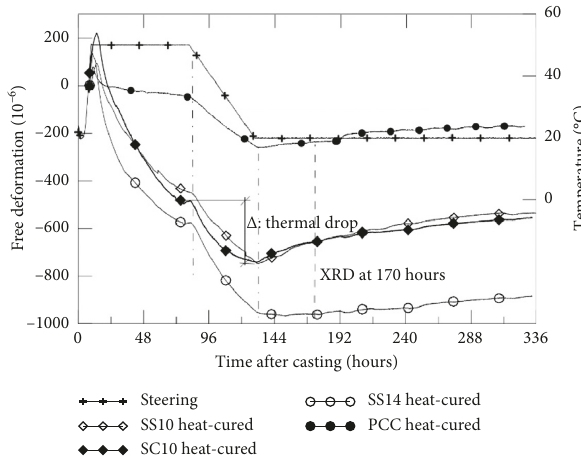
Figure 6: Free deformations on heat-cured samples,